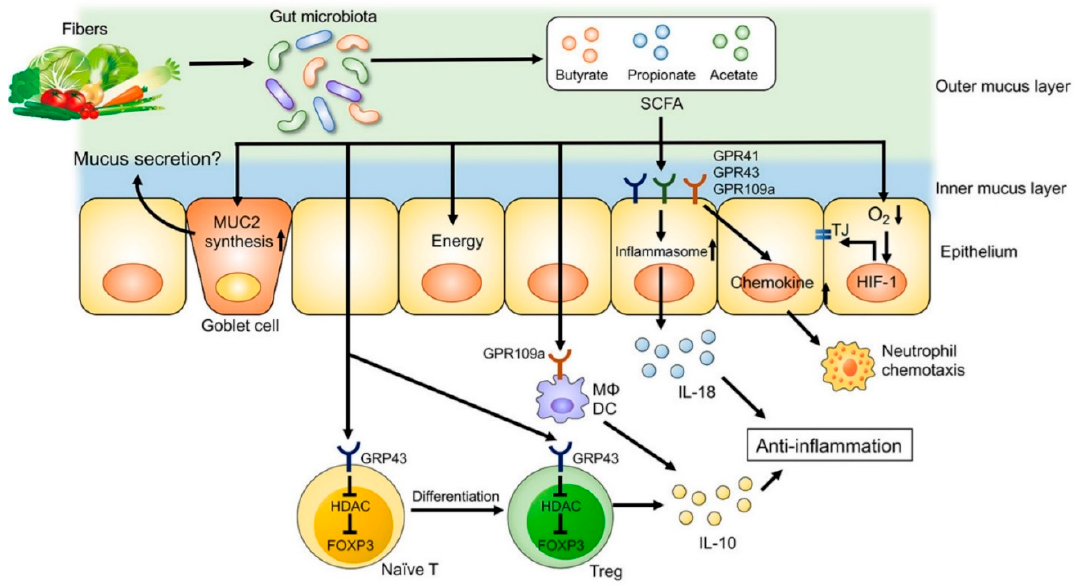
Figure 3. The role of fiber-derived short chain fatty acids (SCFAs) in regulation of intestinal homeostasis. SCFAs serve as energy substrates for colonocytes. In addition, SCFAs regulate intestinal barrier function and immune system through G-protein-coupled receptors (GPRs) signaling. SCFAs promote the differentiation of regulatory T (Treg) cells and the production of interleukin (IL)-10 through GPR43. Furthermore, SCFA facilitate inflammasome activation in colonic epithelial cells through GPR43, stimulating IL-18 production that is critical for anti-inflammation and epithelial repair. SCFAs also regulate intestinal barrier function via enhancing the expression of tight junction proteins and the synthesis of mucin (MUC)2. DC, dendritic cells; FOXP3, forkhead box P3; HDAC, histone deacetylases; M ϕ , macrophages; TJ, tight junctions. [Adapted with permission [22]].